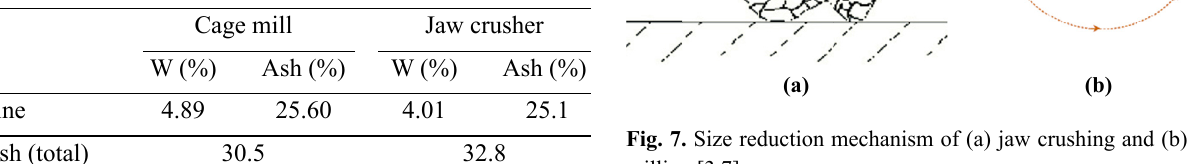
Table 4. Determine the amount of fine in the middle materials (after crushing with different forces).